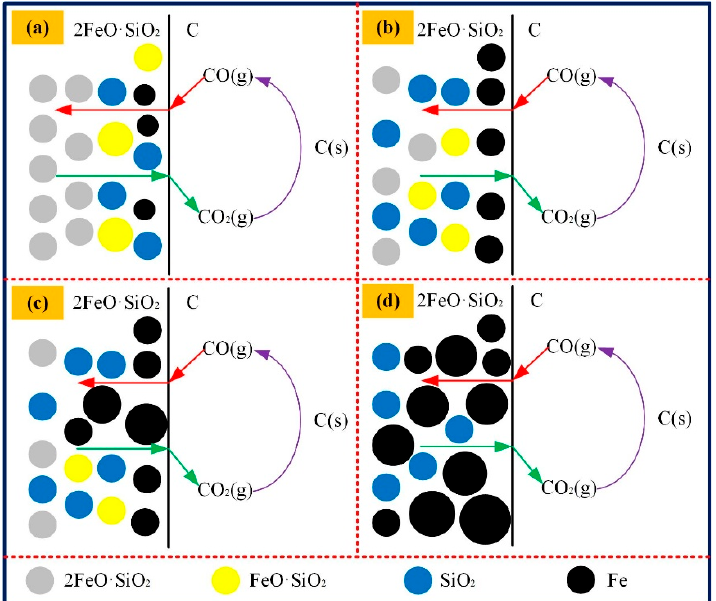
Figure 17. Schematic diagram of metallic iron growth during the coal-based reduction. ( a ) The diffusion of CO; ( b ) Initial stage of iron particle formation; ( c ) Middle stage of iron particle formation; ( d ) Last stage of iron particle formation. Table 4. The main chemical composition of magnetic concentrate /%.